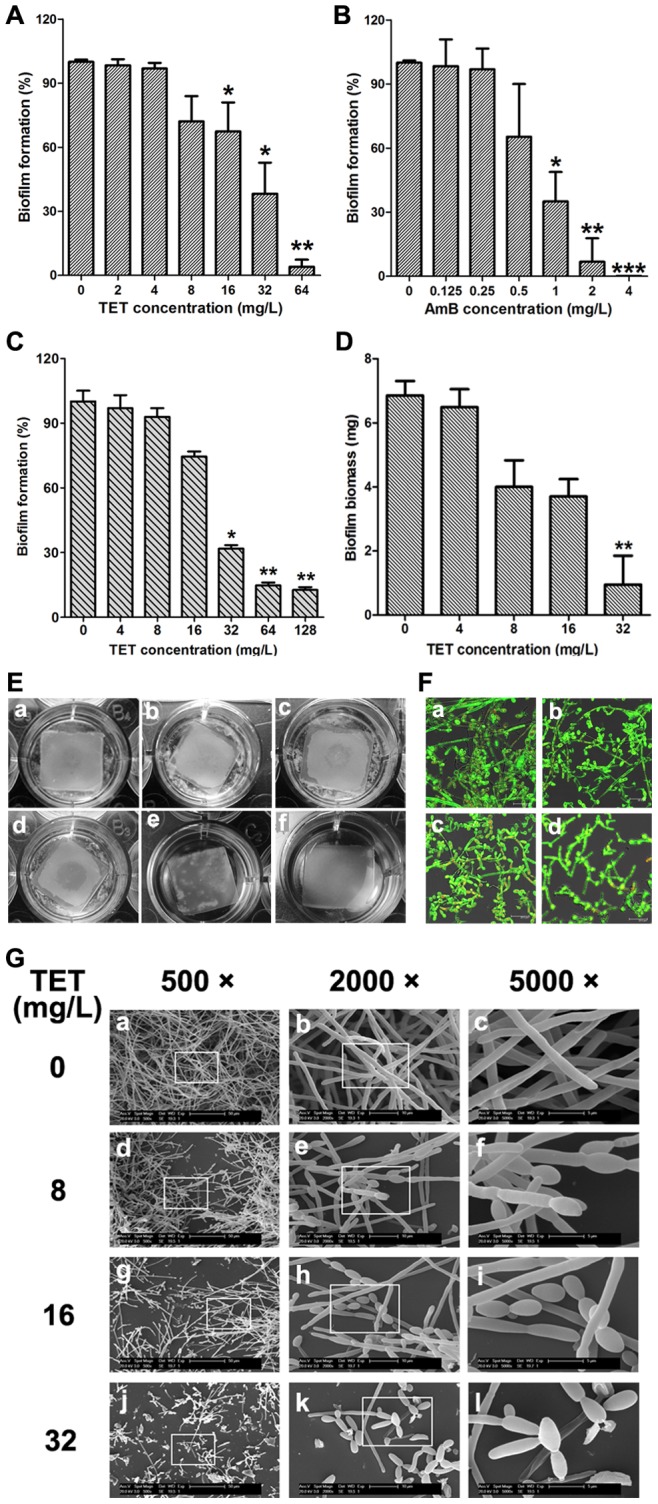
TET inhibits C. albicans SC5314 biofilm formation in vitro.(A) Effects of different concentrations of TET on biofilm formation. (B) Effects of different concentrations of Amphotericin B on biofilm formation. AmB: amphotericin B. (C) Effects of different concentrations of TET on the maintenance of mature biofilms. Biofilm formation was evaluated by XTT reduction assay, and the results were presented as the percentage compared to the control biofilms formed without TET treatment. Biofilm formation results represent the mean ± standard deviation for five independent experiments. * P<0.05 compared to the control biofilms, ** P<0.01 compared to the control biofilms. (D) Effects of different concentrations of TET on biofilms formed on silicone pads. Standard deviations are depicted and based on 6 silicone pad measurements. ** P<0.01. (E) Screen for TET-treated biofilms formed on silicone pads. The wells are shown for a: normal biofilm. b: cells were treated with 4 mg/L TET. c: 8 mg/L TET. d: 16 mg/L TET. e: 32 mg/L TET. f: uninoculated control. (F) Effects of different concentrations of TET on biofilm formation presented by using CLSM. a: Control. b: 8 mg/L of TET. c: 16 mg/L TET. d: 32 mg/L TET. (G) Effects of different concentrations of TET on biofilm formation presented by using SEM. The inset in the 500 ×, 2000× panels show the area that was magnificated.